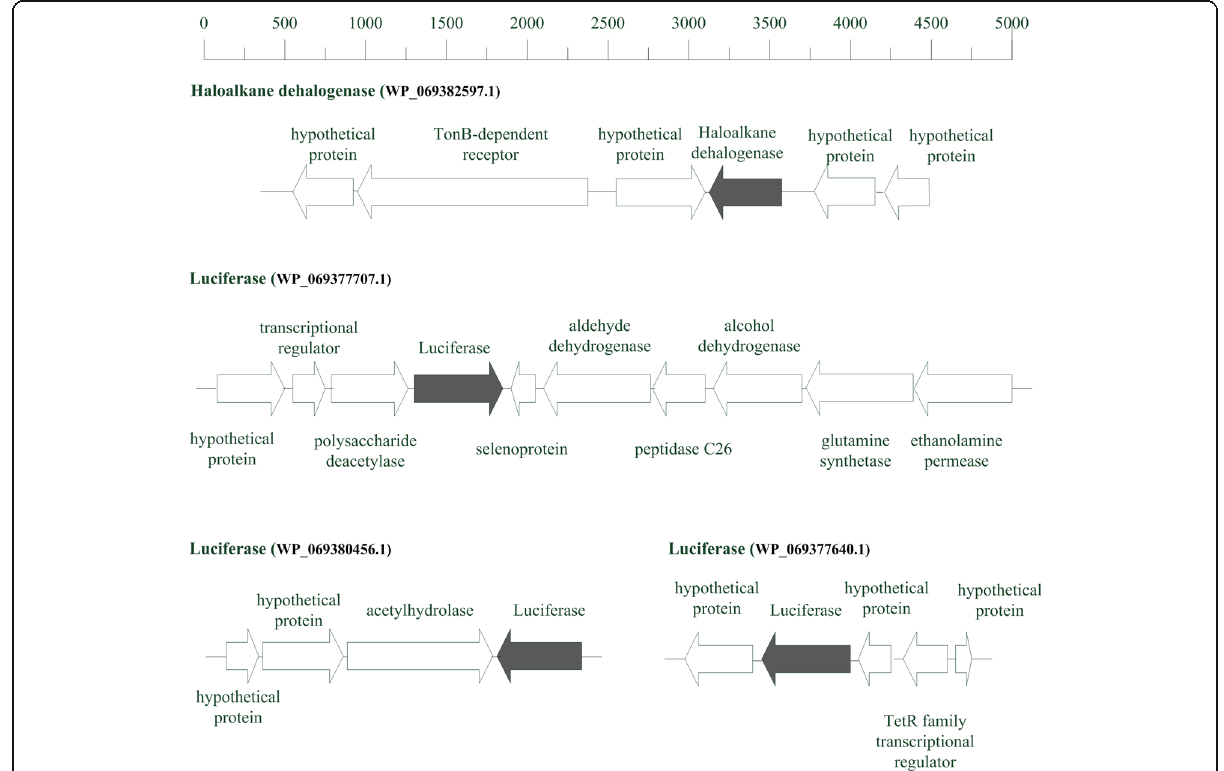
Fig. 6 Organization of Genes coding for HLD and luciferase and their adjacent genes in P. steynii strain DX4